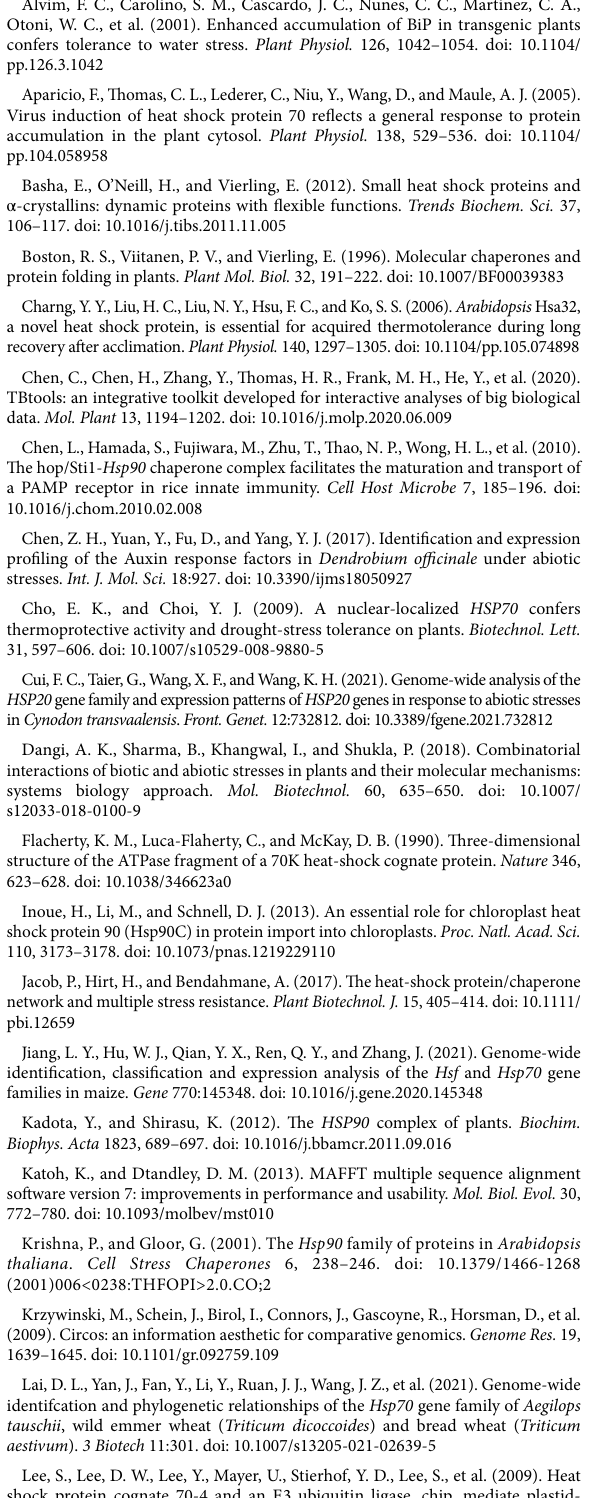
similar functions are displayed in the same color. (B) The detailed percentages of each type of cis -elements. (C) The percentage of three kinds of cis